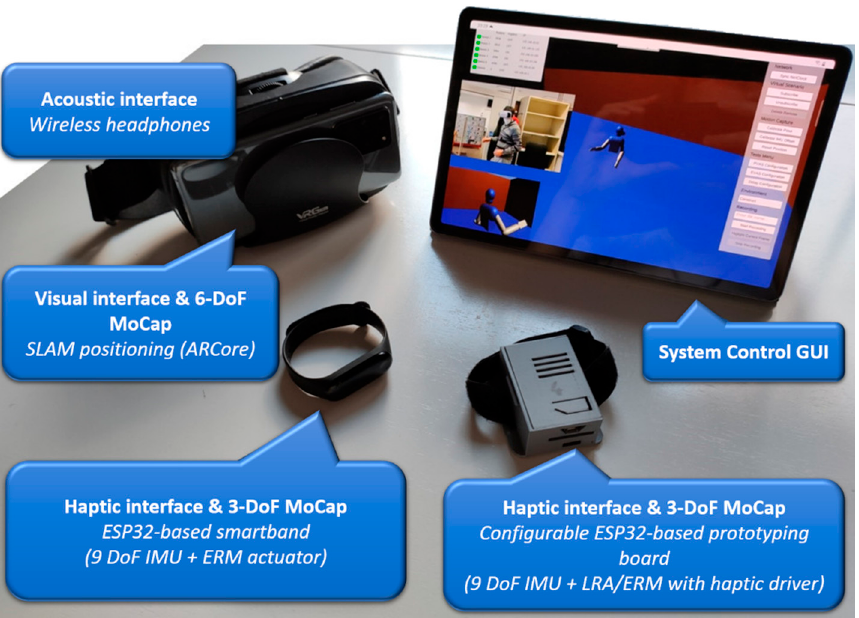
Figure 1. The VES system (the image in the tablet is a capture of the GUI and a photo of the